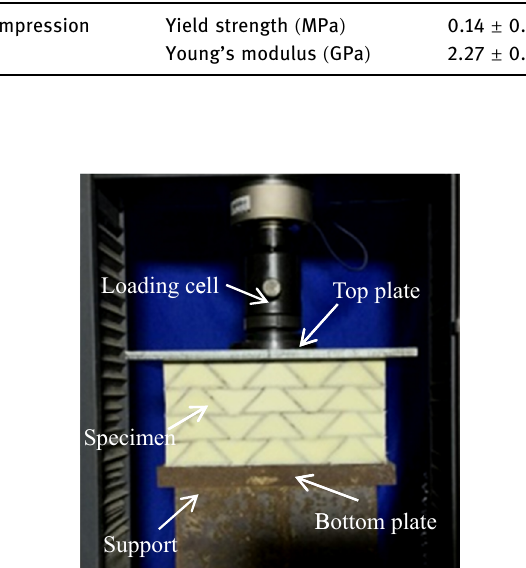
Figure 4: Quasi - static experiment on foam sandwich composite with spatial reinforced lattice webs.